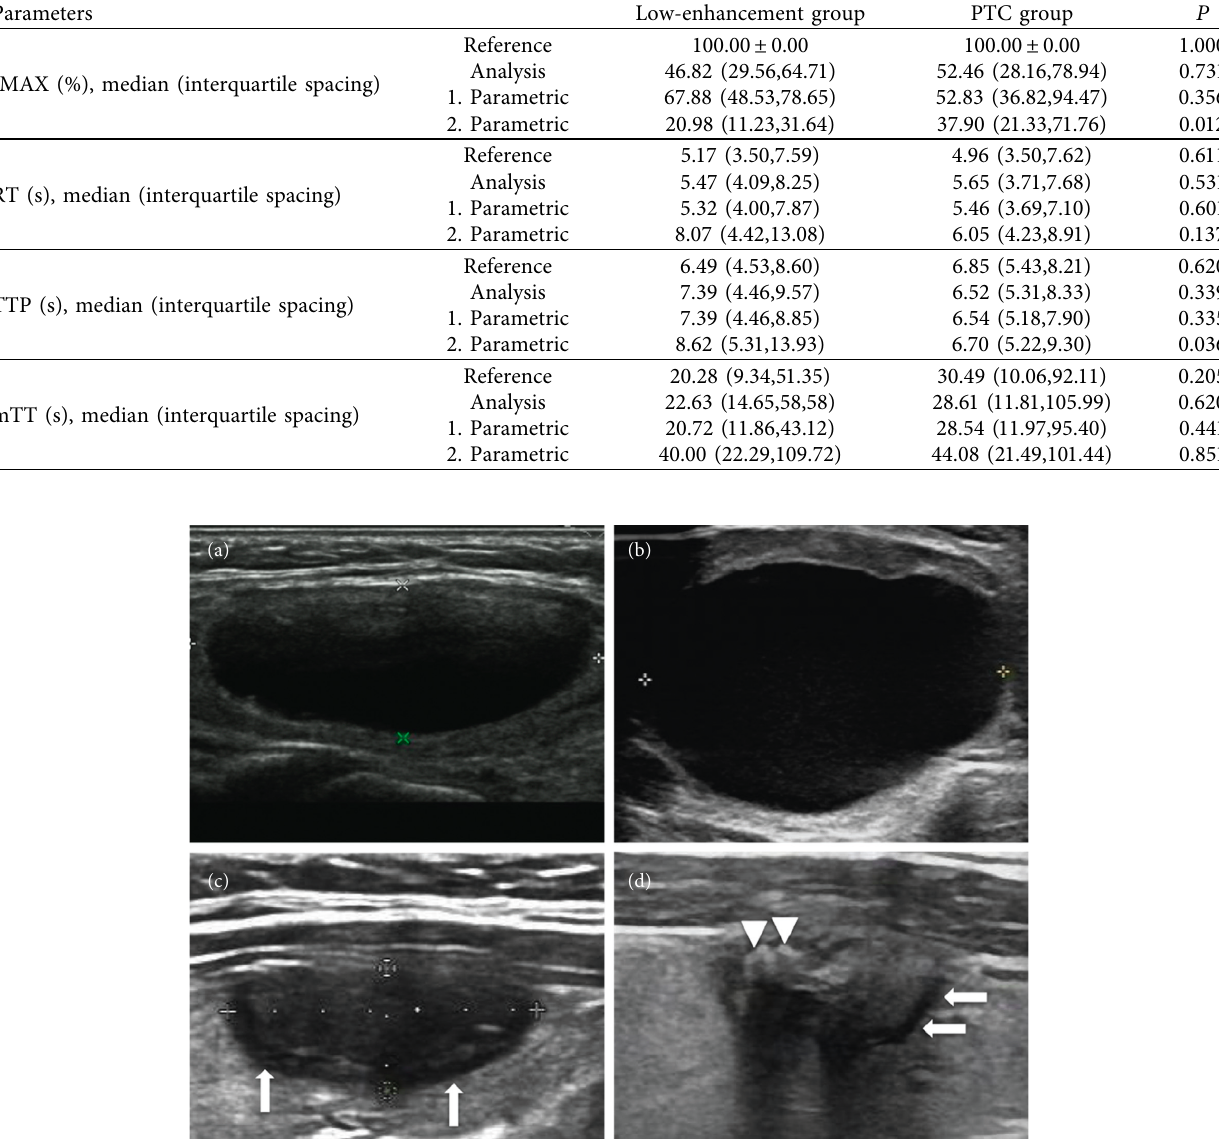
Table 3: Comparison of CEUS parameters between the low-enhancement and the PTC groups.